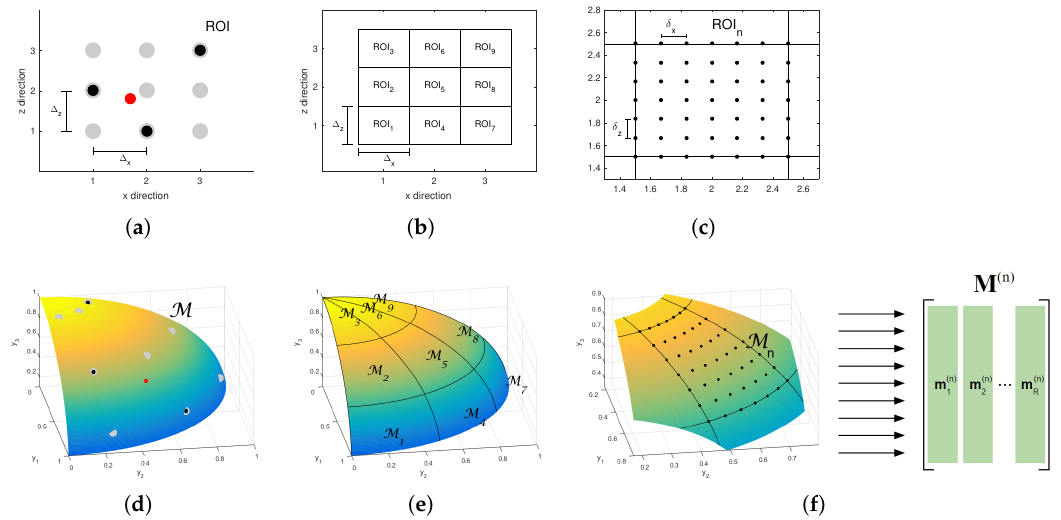
Figure 2. ( a ) an illustrative discrete acquisition model with N = 3 × 3 = 9 modelled positions, represented by the gray dots. The black dots represent three well located events and the red dot represents an off-grid event. Because of the latter, the corresponding acquisition data vector c cannot be synthesized as a linear combination of the columns of the discrete model matrix H ; ( b ) the region of interest (ROI) is divided into N local ROIs with area ∆ x × ∆ z ; ( c ) each local ROI is sampled with a fine grid with lateral and axial distances δ x and δ z ; ( d ) on the space R M of acquired data, the set of all possible point spread function (PSFs) within the ROI form a manifold M . The gray dots are the PSFs of the modelled positions of Figure 2a. The black dots are on the grid, while the red dot is off-grid; ( e ) as the ROI is divided into N local ROIs (Figure 2b), the manifold is divided into N corresponding local manifolds; ( f ) the acquisitions over the fine grid on each n -th local ROI create R samples from the corresponding local manifold. Those samples compose matrix M ( n ) ∈ R M × R